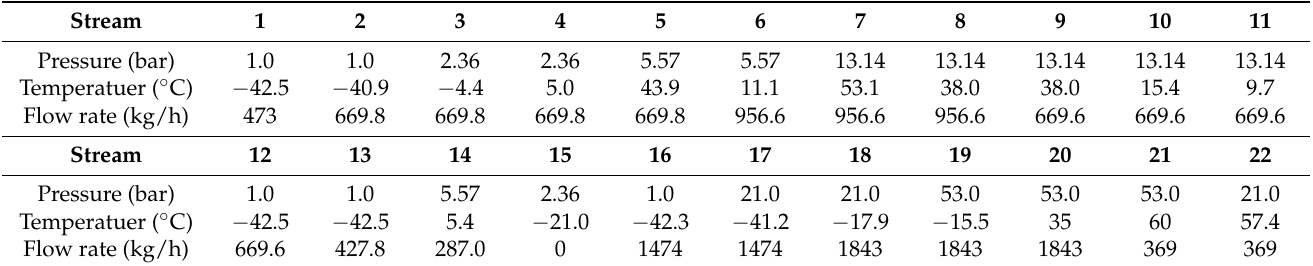
Table 3. Stream information of the conventional re-liquefaction system with